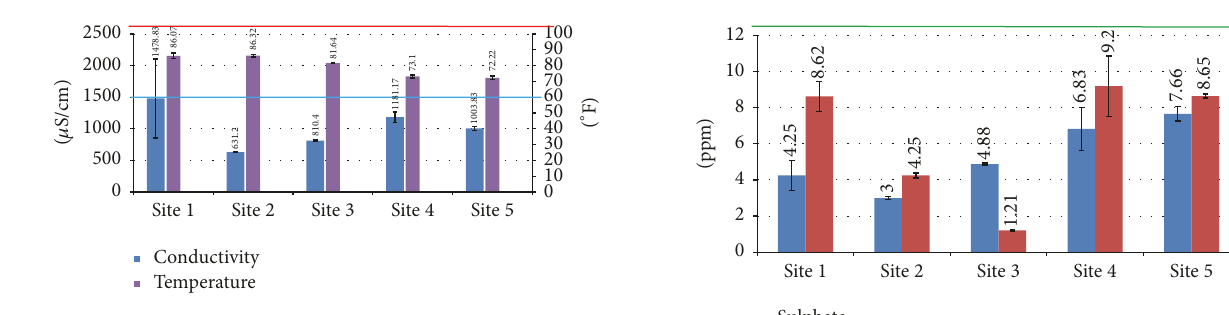
Figure 4: Graphs showing the conductivity and temperature levels with their respective error bars on standard deviation, observed in the samples of 5 sites of this study, along with the ECR tolerable limit for temperature (104 ∘ F) as shown by red line and NDWQS tolerable limit for conductivity (1500 𝜇 S/cm) as shown by blue line.